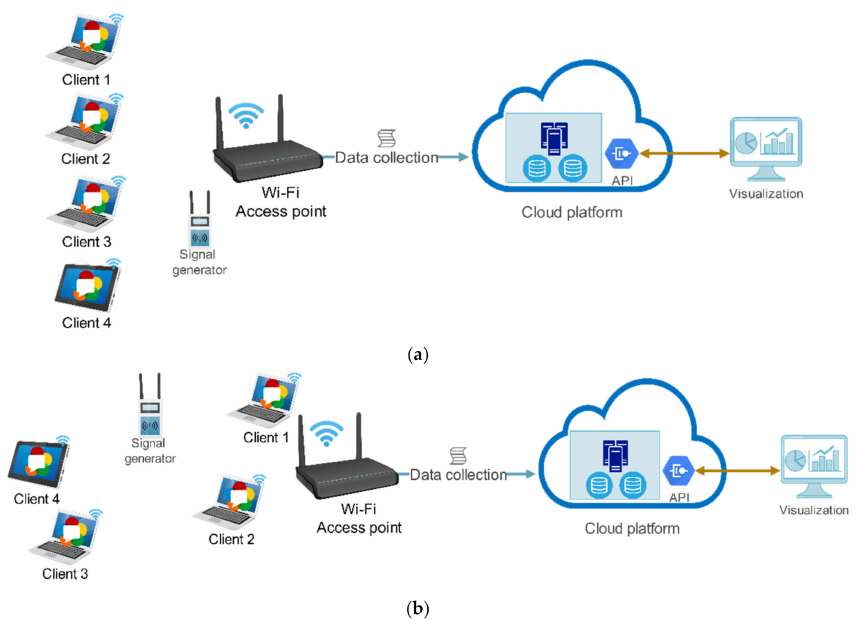
Figure 1. The experimental setup ( a ) when all clients were close to Wi-Fi access point (AP) and ( b ) when clients were placed in different